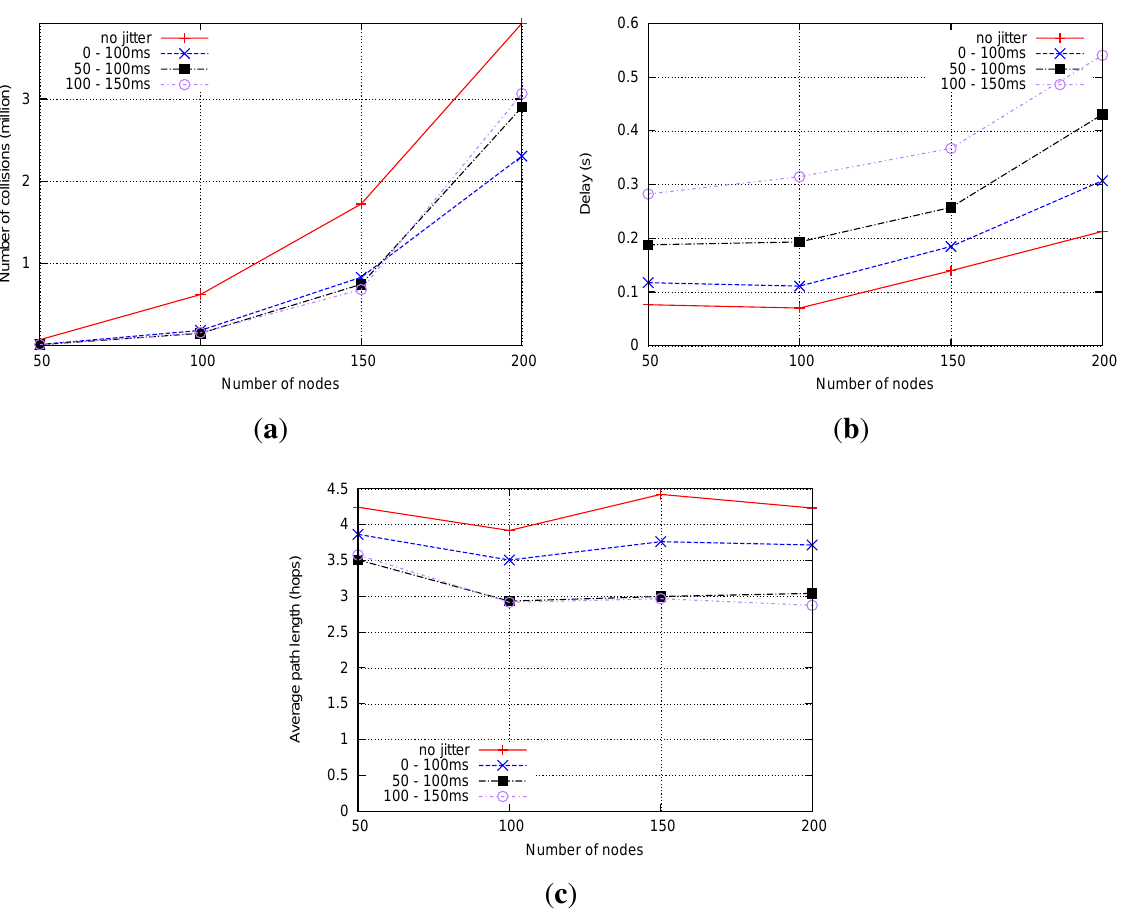
Figure 18. Simulation results of shortest-delay RREQ forwarding. ( a ) The number of collisions; ( b ) The average route discovery delay; ( c ) Average path